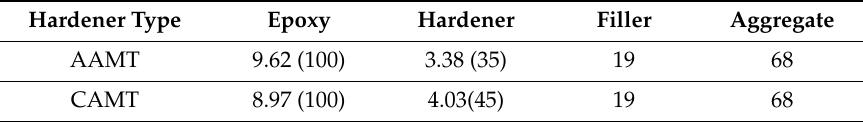
Table 7. Mix proportions of ER concrete (unit: wt %).